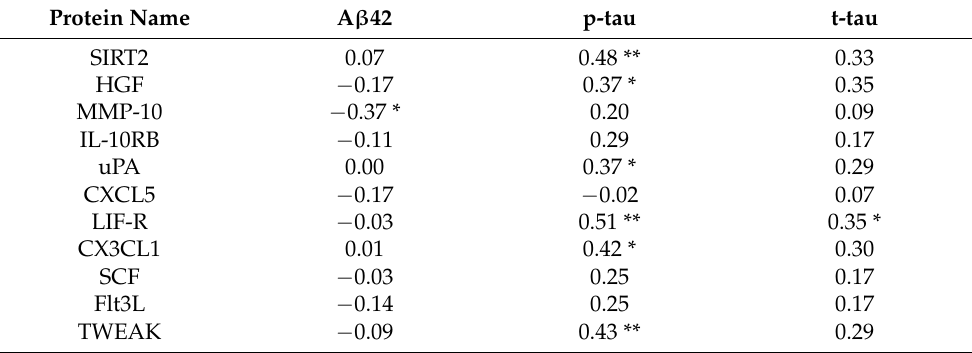
Table 2. Spearman’s correlation coefficients between the most discriminatory PEA-tested proteins and classical AD biomarkers within the AD-MCI group. For abbreviations of PEA-tested proteins, see Table S1.